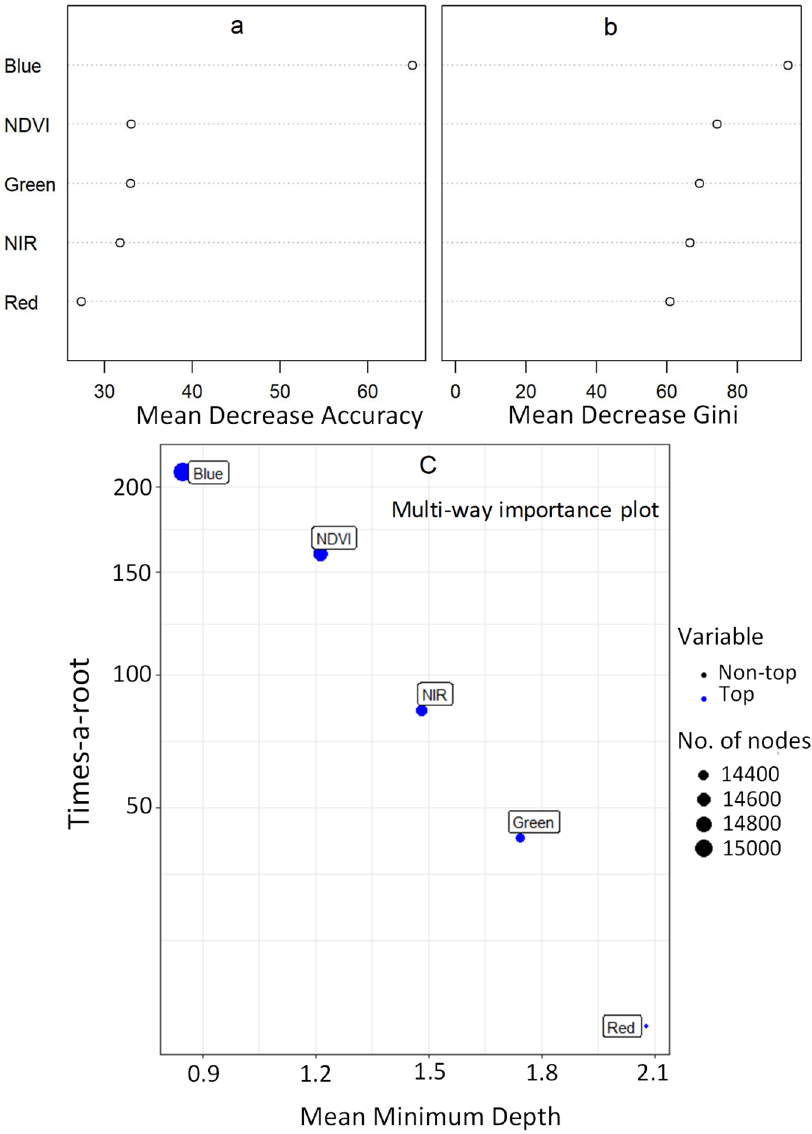
( c ) multiple way importance plot showing the magnitude of contribution to RF classification between the classes Jacaranda mimosifolia, Platanus × acerifolia (London Plane) and other vegetation types in the city of